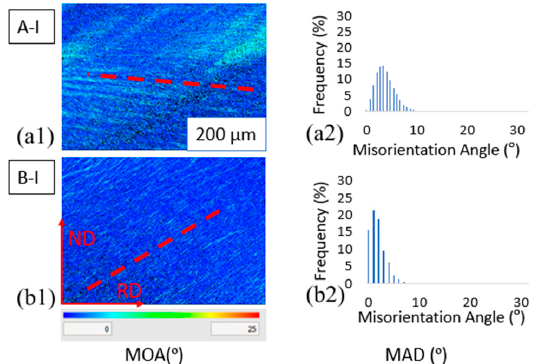
Figure 6. ( a1 , a2 ) and ( b1 , b2 ) are EBSD results for A-I and B-I. ( a1 , b1 ) are the MOA maps of deformed crystals. Red dashed lines represent the alignment of the most apparent DBs set. ( a2 , b2 ) represent the MAD for deformed crystals.